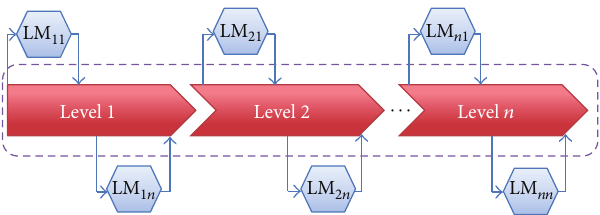
Figure 1: Diagram of our methodology; a game with several levels and the learning mechanisms associated to each